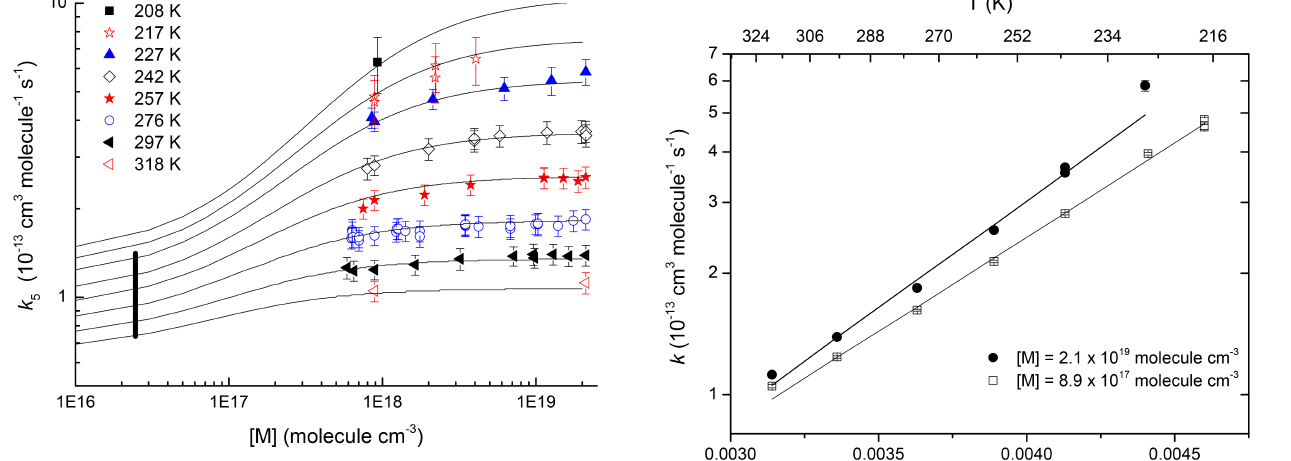
Figure 7. Rate coefficients k 5 as a function of pressure and tem- perature from this work (error bars represent total uncertainty). The solid lines are fits to the entire data set with expression (3). Data at 246 and 239K are omitted to preserve clarity of presentation. The vertical line at [ M ] = 2 . 5 × 10 16 moleculecm − 3 (220–330K) rep- resents the data set used to guide the fit at low pressures and is given by the expression k 5 = 2 × 10 − 14 exp ( 430 /T ) cm 3 molecule − 1 s − 1 .